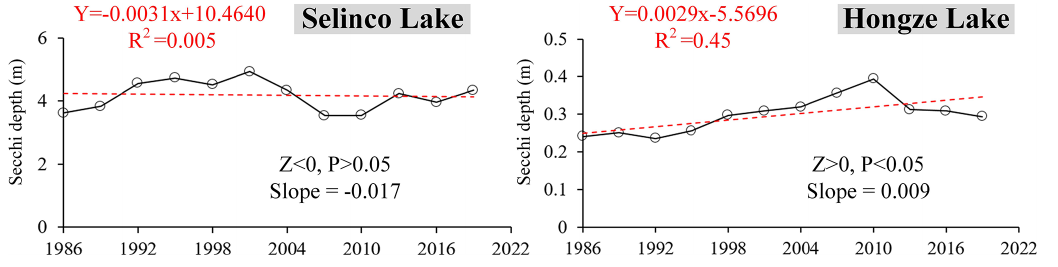
Figure 7. The long-term SD curves of Selinco Lake and Hongze Lake.